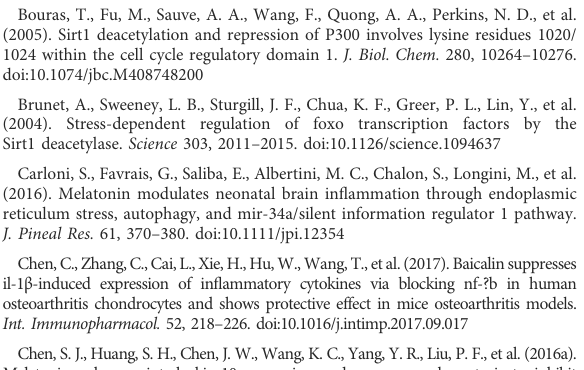
SUPPLEMENTARY FIGURE S1 The colocalization of SIRT1 with IRE1 by Immuno fl uorescence (bar, 20 μ m). SUPPLEMENTARY FIGURE S2 Effectsoflong-term melatonintreatment onbodyweightwith aging.10- weeks mice were divided into sham group, OA group, low – dose melatonin (50 mg/kg) and high – dose melatonin (150 mg/kg). Body weights were measured at 0, 2, 4 6, 8, 10, 12 weeks after operation, (each group n = 6). SUPPLEMENTARY FIGURE S3 Melatonin attenuates the activation of PERK pathway (A) Melatonin attenuated the phosphorylation of PERK. (B) EX527 eliminated the protective effect of melatonin on human chondrocytes stimulated by lipopolysaccharide by inhibiting the phosphorylation of